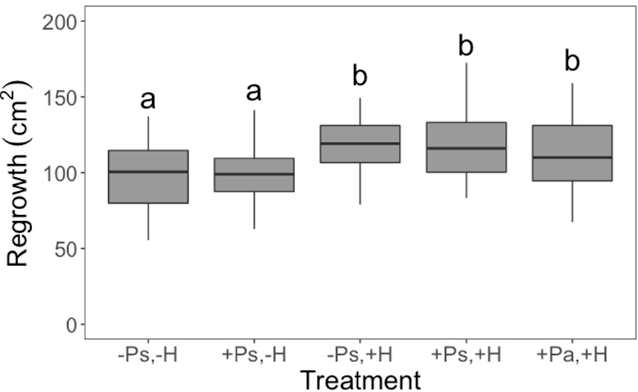
Figure 2. Effect of herbivory (H) on plant regrowth. Boxplots representing the median, minimum and maximum values are shown. Plants that experienced 50% of damage increased their leaf area relative to undamaged plants. Plus (+) and minus ( − ) signs denote the presence/absence of the treatment; Ps and Pa denote priming being performed by a sympatric or allopatric insect, respectively. Different letters denote significant differences following a Tukey–Kramer test ( p < 0.05). There were 24 replicates (plants) per treatment ( n = 120).